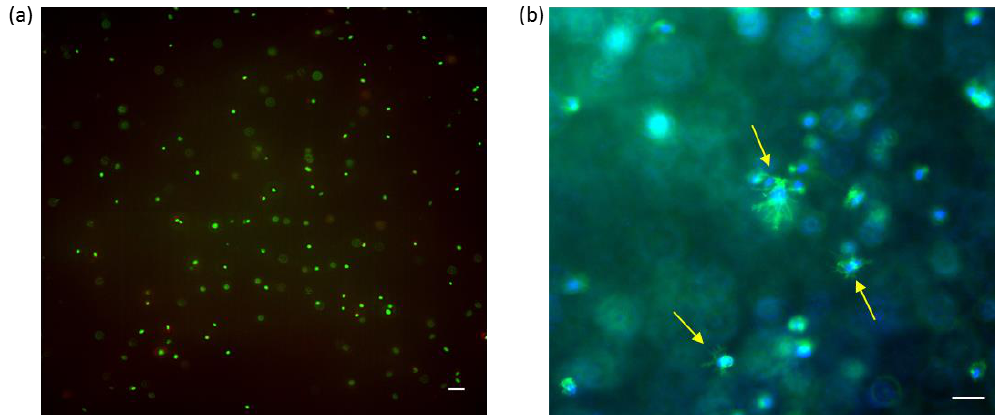
Figure 6. Normal human dermal fibroblasts (NHDF) in HA-DTPH 58% -dHA + hydrogel. ( a ) Live/Dead staining of NHDF embedded in HA-DTPH 58% -dHA + . Homogenous distribution of NHDF cells inside the hydrogel. Living cell (green fluorescence) and dead cell (red florescence). Image was taken as a Z-stack and max. intensity was performed via ImageJ. Scale bar = 50 µm ( b ) Composite images taken from NHDF embedded in HA-DTPH 58% -dHA + −5% RGD hydrogel. Spreading of fibroblasts (indicated with yellow arrows) was observed 24 h post-embedding inside the hydrogel. Cell nuclei are stained with DAPI. Actin is directly stained with phalloidin. Scale bar = 50 µm.